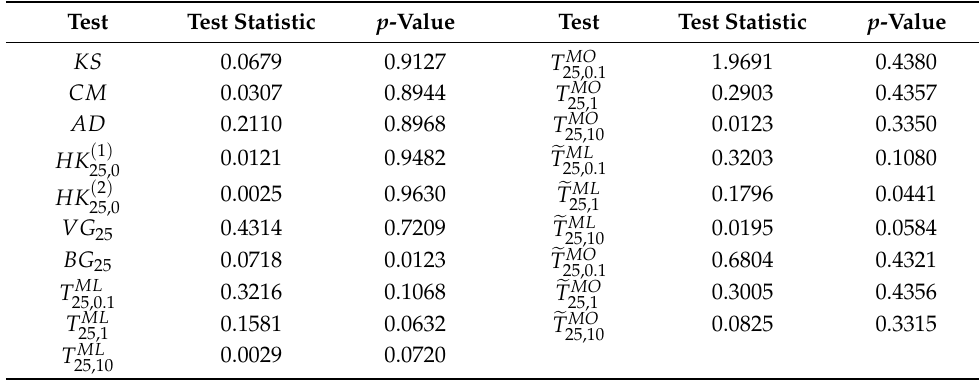
Table 7. Values of the test statistics and p -values for the precipitation